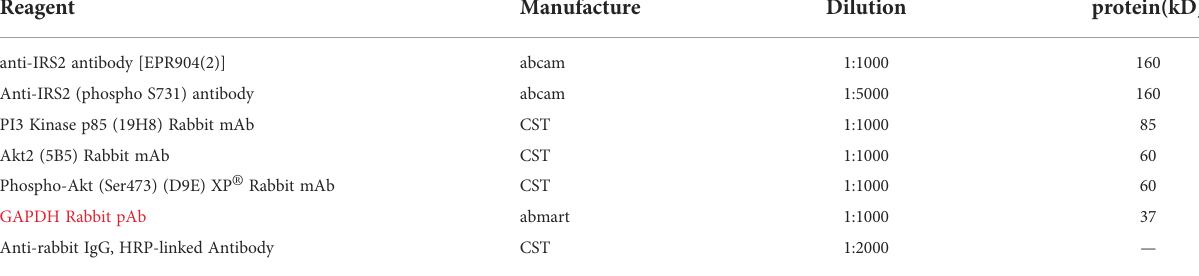
TABLE 1 Reagent information required for western blot.